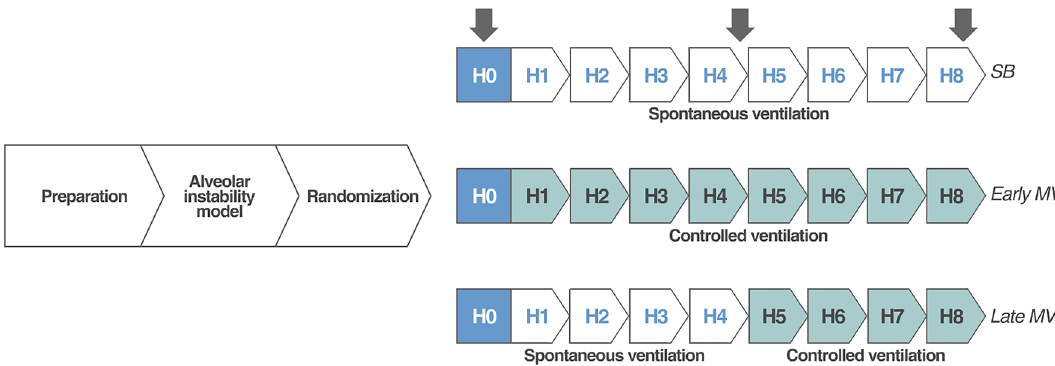
Figure 1. Study design and timeline. Preparation corresponds to anesthesia and invasive monitoring, which took around 2 h, baseline was measured at the end of this period. Alveolar collapse model corresponds to partial surfactant depletion and lung collapse model. After induction of the model, animals were randomized for spontaneous breathing, early controlled MV and late controlled MV by a period of 8 h. Arrows: data record